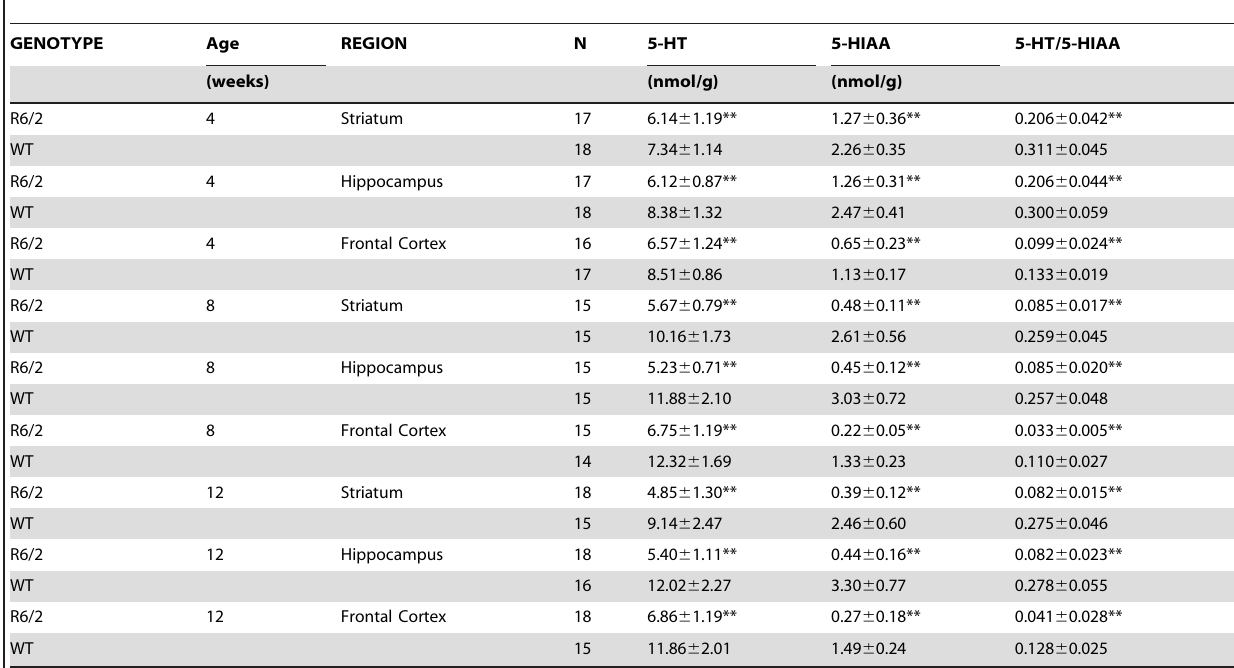
Table 2. Profile of serotonin metabolites in brain of WT and R6/2 mice at 4, 8 and 12 weeks of age.